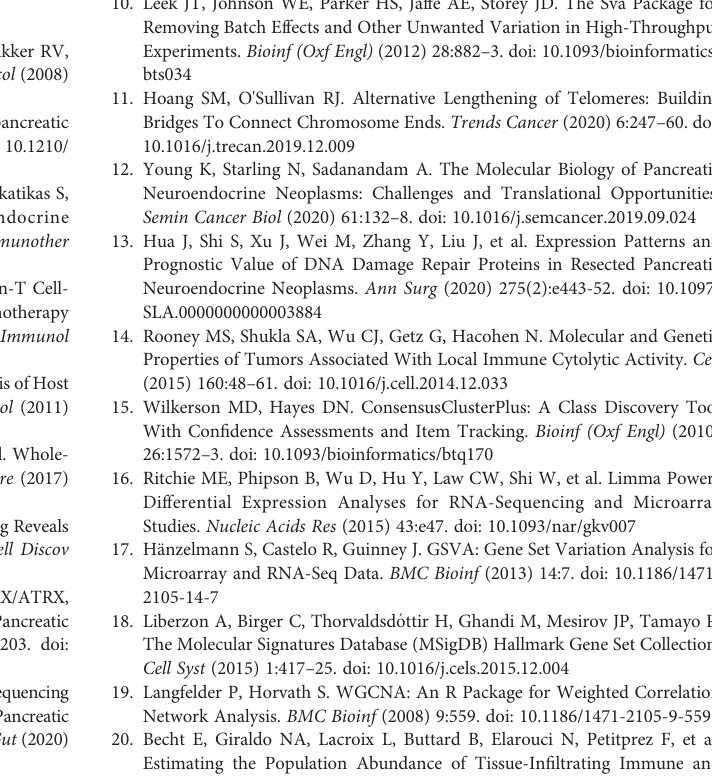
Supplementary Figure 1 | The overall stain intensity of these markers (SMARCA4, MLH1, TSC1, ATRX, and ATR) include “ strong ” , “ moderate ” , “ weak ” , “ negative ” , and we score these intensity levels “ 3 ” , “ 2 ” , “ 1 ” , “ 0 ” , respectively. Supplementary Figure 2 | The relationship between IHC score of these markers (SMARCA4, MLH1, TSC1, ATRX, and ATR) with clinical data. (A) The expression of these markers between adjacent tissue with tumor tissue by IHC. (B) The relationship of expression of these markers with recurrence free survival. (C) The relationship of expression of these markers with live metastasis. Supplementary Figure 3 | The speci fi c signaling pathways among the four subtypes. (A) Heatmap of median relative expression of the cancer-related pathways among the four subtypes. (B) Box of median relative expression of metabolic-related signaling pathways among the four subtypes. Supplementary Figure 4 | Correlation map of fi ve pathways-related molecules expression in 130 validated primary samples. Supplementary Figure 5 | Expression of the fi ve pathways-related molecules was associated with an active immune phenotype in an independent GEP-NENs cohort. (A) Heatmap of ssGSEA scores of gene sets characteristic of speci fi c immunecellpopulationsusingthesamecell-relatedsignatures. (B) Thecomparison of PI_Score and PC_Score among the four subtypes in validated cohort. (C) Heatmap of median ssGSEA scores of speci fi c antitumor immune responses associated with T cell activation among the four subtypes. (D) Heat map of median ssGSEA scores of gene signatures upregulated in speci fi c antitumor immune responses related to APC activation among the four subgroups. (E) Box of median ssGSEA scores of DC including cDCs, iDCs, pDCs and aDCs among the four subtypes. (F) ssGSEAscoresoftwoin fl ammation signatures(parain fl ammation and in fl ammation promoting). (G) The comparison of immunosuppressive cytokines, enzymes, signaling pathways, checkpoints and cell surface molecules among the four